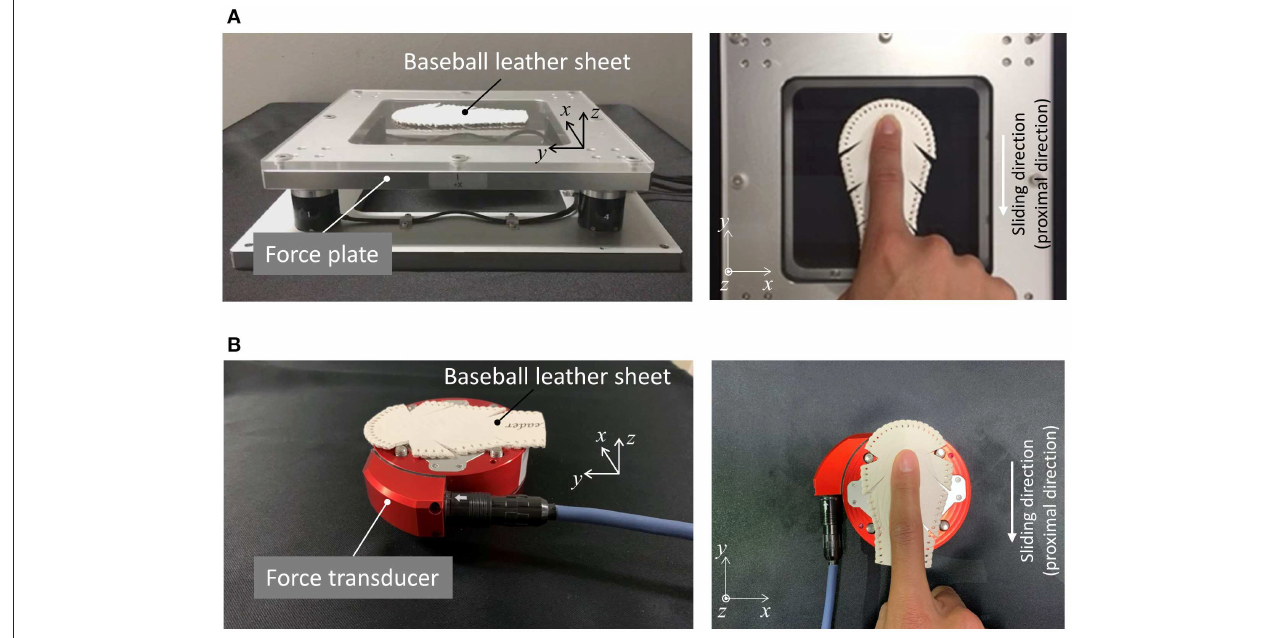
FIGURE 1 | Experimental setup (A) for the low normal force condition ( F z ≤ 10N) and (B) for large normal force condition ( F z > 10N).